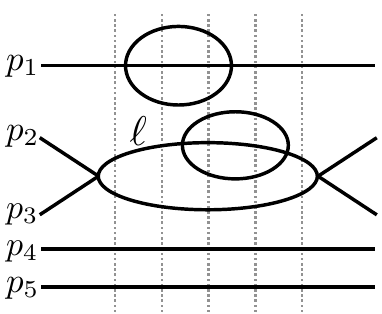
Figure 16 . Example of an O ( g 6 ) contribution in perturbation theory involving multiple sunset subdiagrams. The finite state-dependence for all such higher order processes is set only by the momentum fraction carried by the individual sunset diagrams (for this example, p 1 − just like for second-order